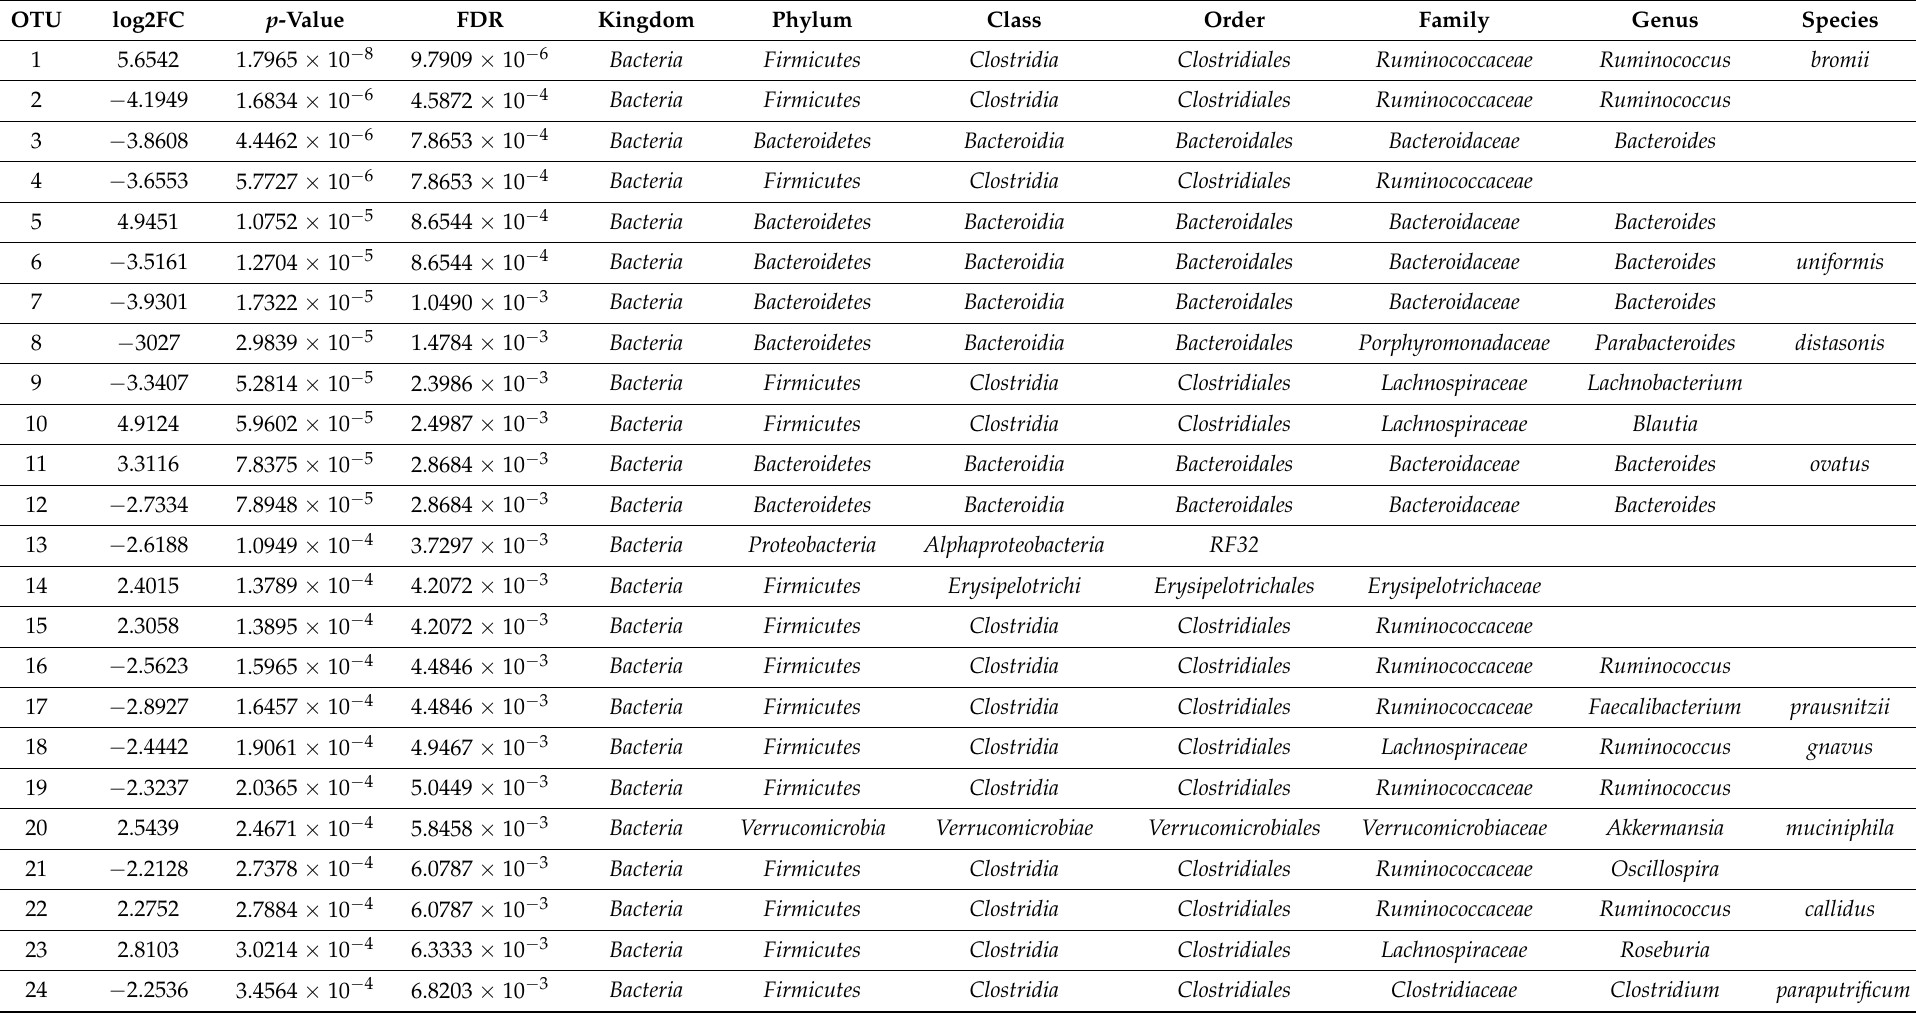
Table 3. Changes in the Operational Taxonomic Units (OTUs) induced by the low-calorie diet with respect to the baseline and the relative taxonomic classification. log2FC (fold change). FDR: False Discovery